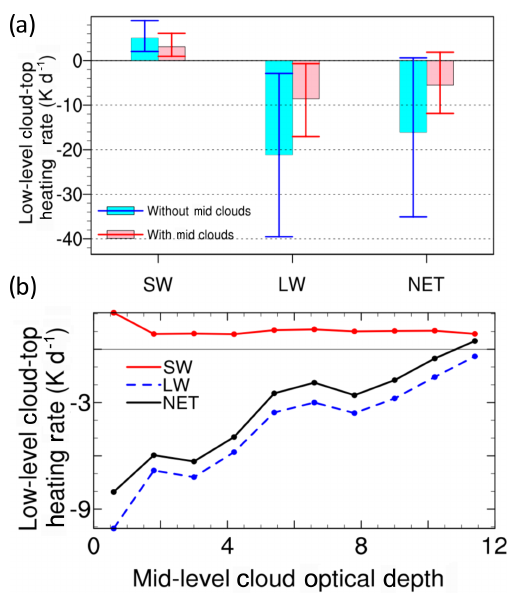
Figure 8. The radiative impact of mid-level cloud on the low-level cloud-top heating rates. (a) The instantaneous heating rates at the top of low-level clouds with (pink bars/red lines) and without (cyan bars/blue lines) the presence of collocated mid-level clouds. (b) The instantaneous heating rates at the top of the low-level clouds as a function of the overlying mid-level cloud optical depth. All data are obtained from the CloudSat–CALIPSO merged dataset between July and October (2006–2010) and over the ORACLES-2016 cam- paign region (black boxes shown in Fig. 4) and separated into the shortwave (SW) and longwave (LW) components, as well as the NET (NET = SW + LW).